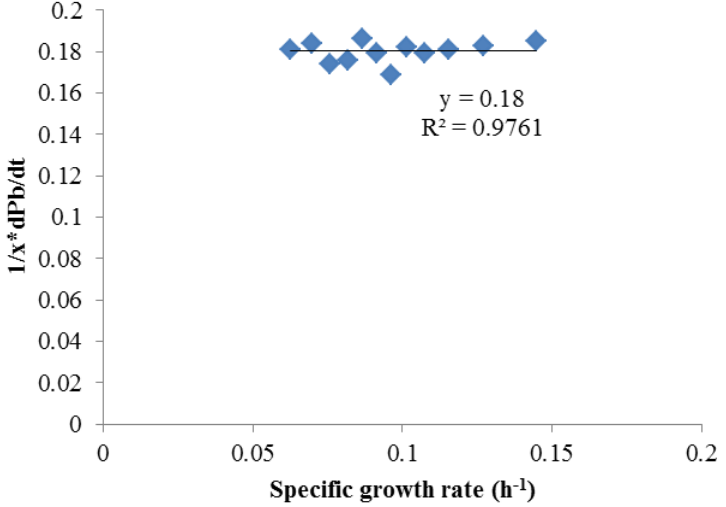
Figure 2. Specific rate of butyric acid formation as a function of specific cell growth rate for batch fermentation at pH 6.2.